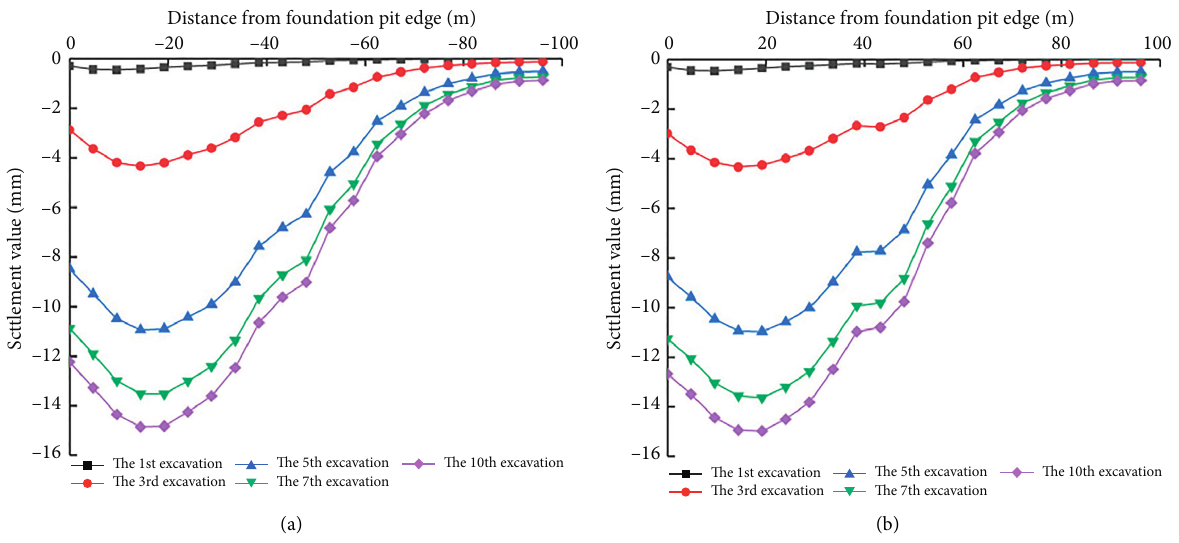
Figure 13: The curve of surface subsidence. (a) West wall. (b) East wall. Table 6: Summary of the corresponding position of the maximum subsidence of the surface. Working